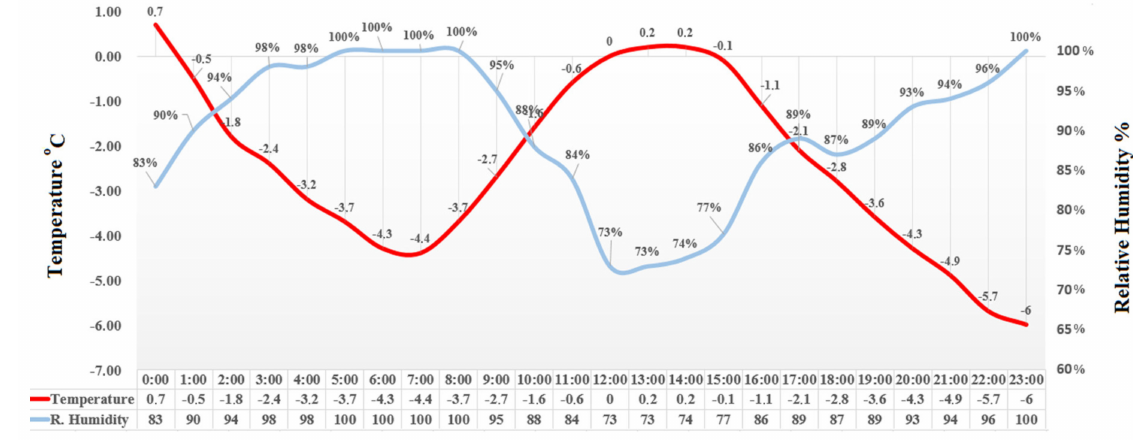
Figure 5. External weather conditions.